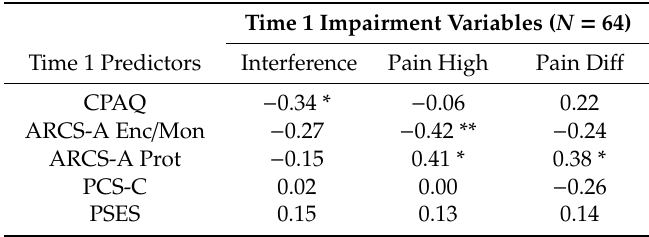
Table 3. Multiple Regression Analyses with Time 1 Adolescent-Reported CPAQ, ARCS-A, PCS-C, and PSES Associations with Time 1 Functional Impairment